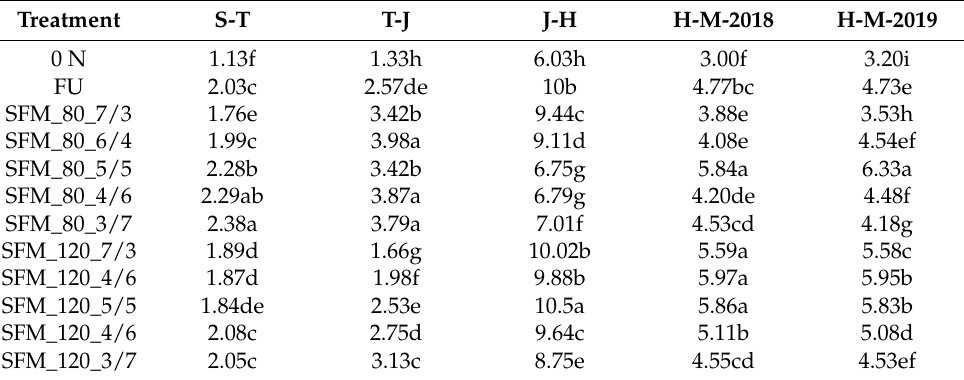
Table 5. Effects of different fertilization modes on the dry matter accumulation (t ha − 1 ) of rice. Treatment